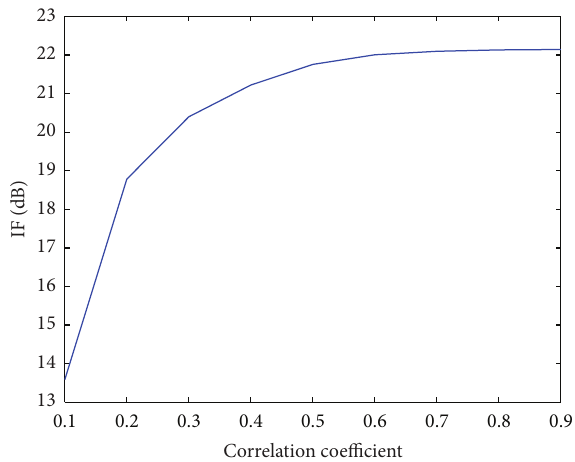
Figure 10: The relationship between the IF and correlation coeffi- cient threshold.